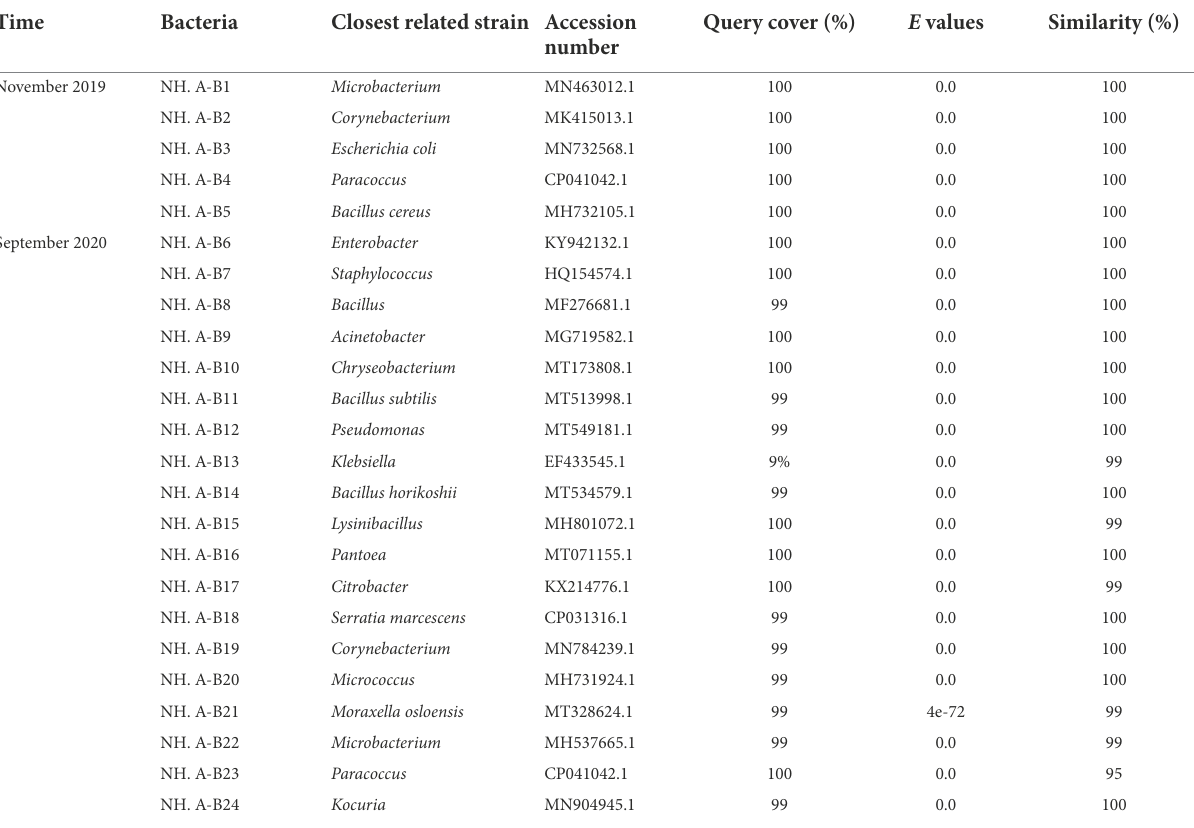
TABLE 1 Molecular identification of bacteria isolated from the air in the protective environment of the Nanhai No. 1 Ancient Shipwreck. Time Bacteria Closest related strain Accession